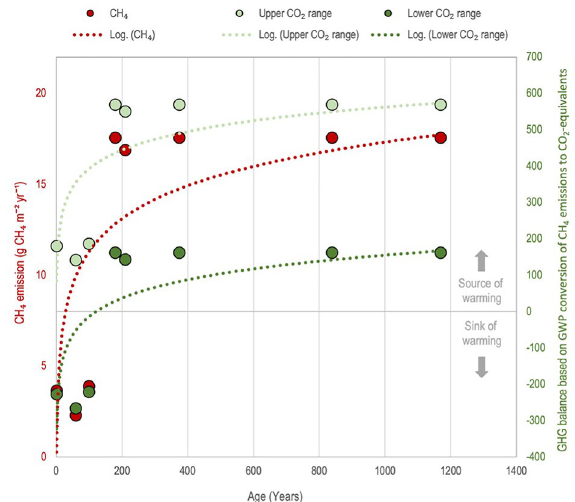
Figure 2. Annual methane emissions plotted against basal peat ages from closest vicinity locations (red dots, left axis). Furthermore, the GHG balance was calculated using a standard global warming potential (GWP) calculation (100 year GWP CH 4 : 28) for methane in CO 2 equivalents combined with the annual fen CO 2 flux range from the 11-year eddy covariance dataset (upper + 23 g CO 2 -C m −2 year −1 , lower – 90 g CO 2 -C m −2 year −1 , respectively; Table S2) (light and dark green dots, right axis). Note the age range (0–100 years) depending on CO 2 sink strength where the fen ecosystem shifts from being a sink to a source of warming-inducing